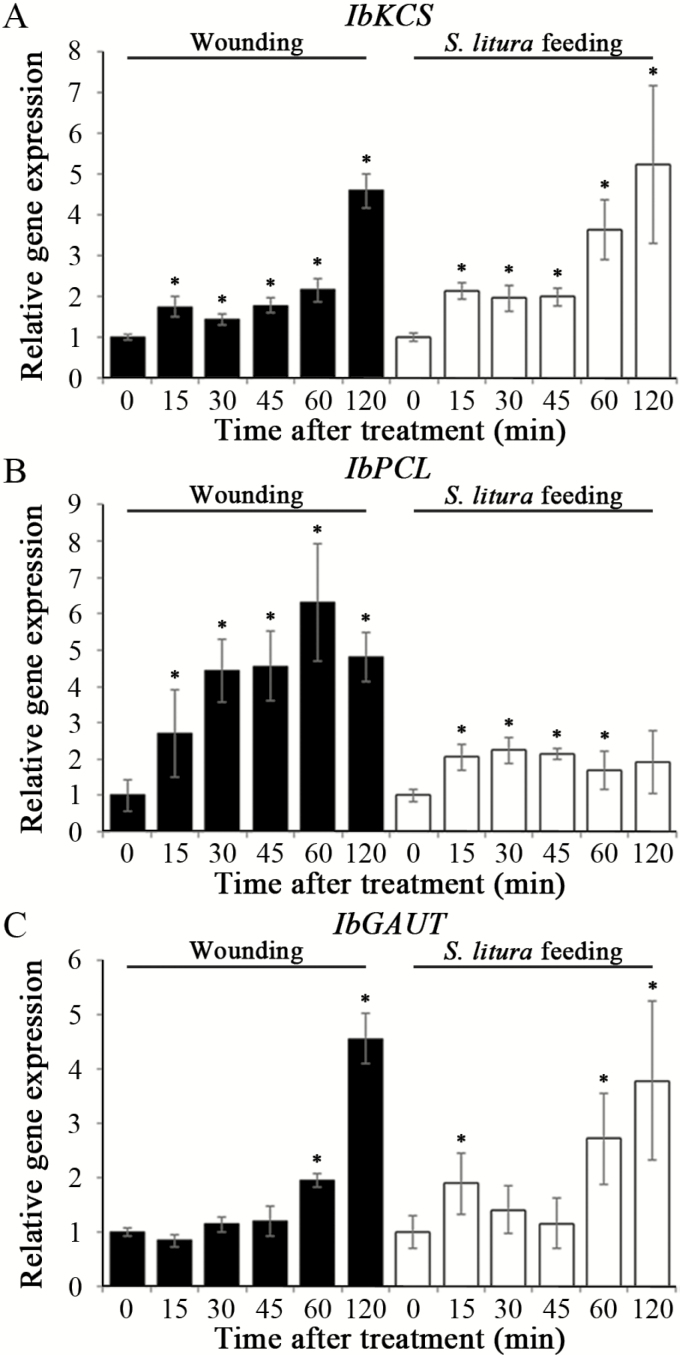
Expression patterns of miR408 target genes upon wounding and insect feeding. The expression of miR408 targets, IbKCS (A), IbPCL (B), and IbGAUT (C) in the leaves of sweet potato wounded by mechanical wounding or insect feeding for 0, 15, 30, 45, 60, and 120 min were analyzed by qRT-PCR. The qRT-PCR results were normalized by the expression levels of IbActin. Data are presented as means ±SD (n=4). The asterisks represent a significant difference from unwounded treatment by Student’s t-test (*P<0.05).